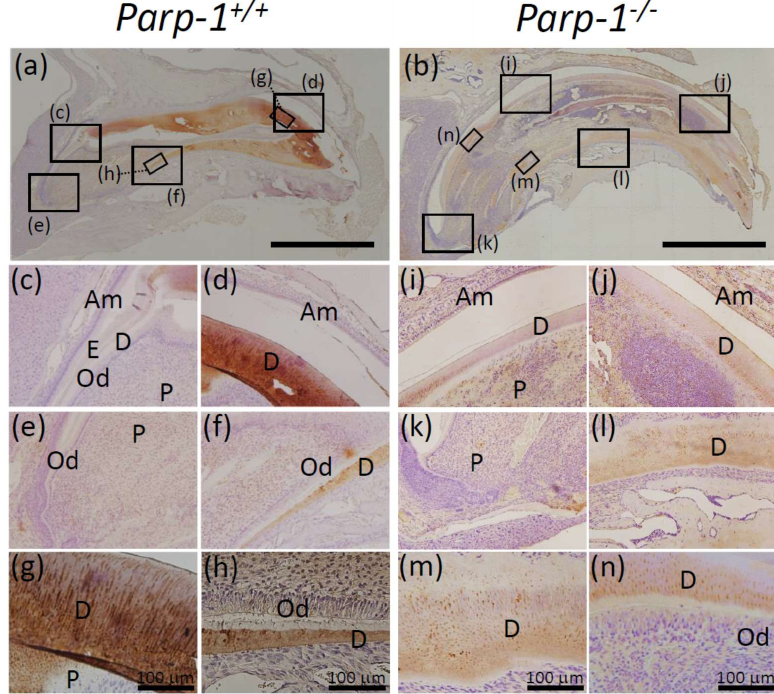
Figure 8. Immunohistochemical analysis of dentin sialoprotein (DSP) expression in aged Parp-1 +/+ and Parp-1 −/− incisors (C57BL/6). The expression of DSP protein in the sagittal plane of Parp-1 +/+ ( a ) and Parp-1 −/− incisors ( b ). Ameroblasts, odontoblasts, pulp and enamel were not reactive to DSP in Parp-1 +/+ incisors ( c , e ). Parp-1 +/+ incisor showed thickly stained DSP at dentin area ( d , f , g , h ), whereas DSP was sparsely stained at the corresponding area in Parp-1 −/− incisor ( i – n ). Moreover, dentinal tubules were clearly observed in dentin area in Parp-1 +/+ incisors ( g ), however, they were hardly observed in Parp-1 −/− incisor ( m, n ). Semi-quantitative analysis showed that the average values of relative intensities of DSP positivity in dentin area were 140.6 ± 10.9 and 59.1 ± 5.6 in Parp-1 +/+ and Parp-1 −/− incisors, respectively ( g , h , m , n ). Am, ameloblast; Od = odontoblast; E = enamel; D = dentin; P = pulp. Bars of ( a , b ) indicate 2 mm. The representative results of a mouse for each genotype are shown.